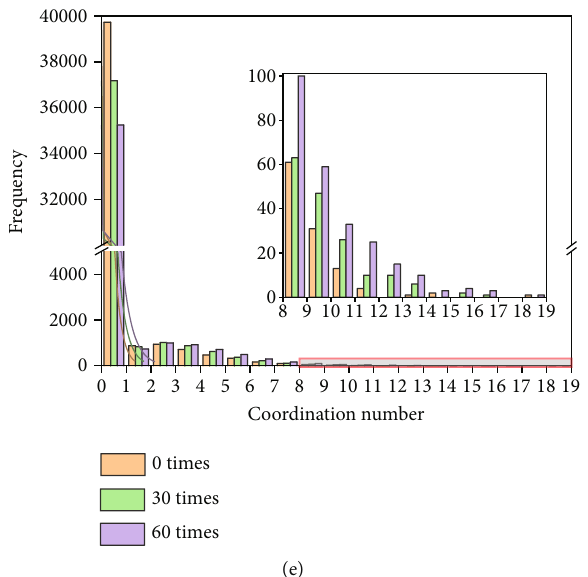
Figure 11: Histogram of the distribution frequency of the pore coordination numbers of fi ve red sandstone samples with di ff erent saturations after 0, 30, and 60 freeze-thaw cycles. (a) A (60%). (b) B (70%). (c) C (80%) (d) (90%). (e) E